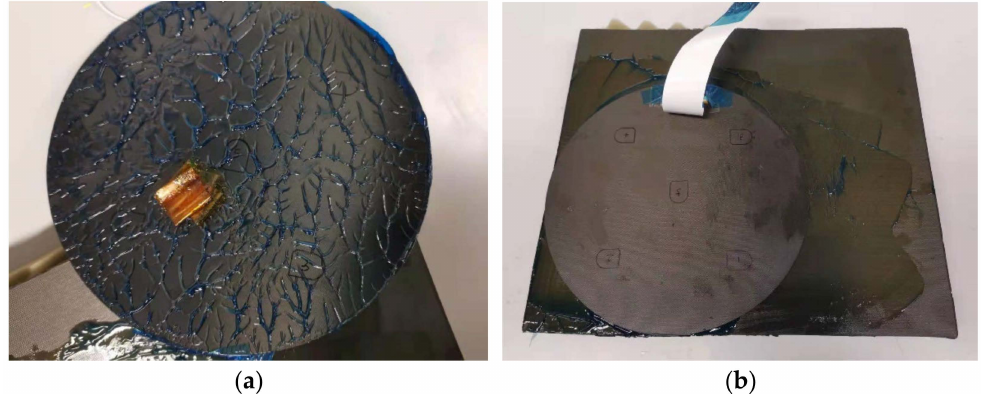
Figure 4. Schematics of ( a ) artificial delamination and ( b ) bonding with blue contact gel for the bonded repair